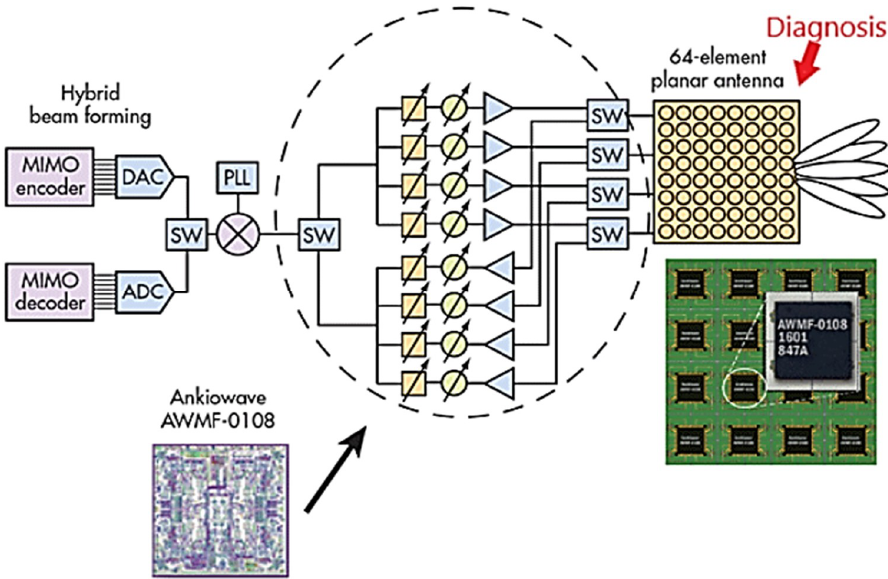
Figure 1. Ka -band active antenna array formation which integrates multiple-input multiple-output (MIMO) and beamforming.